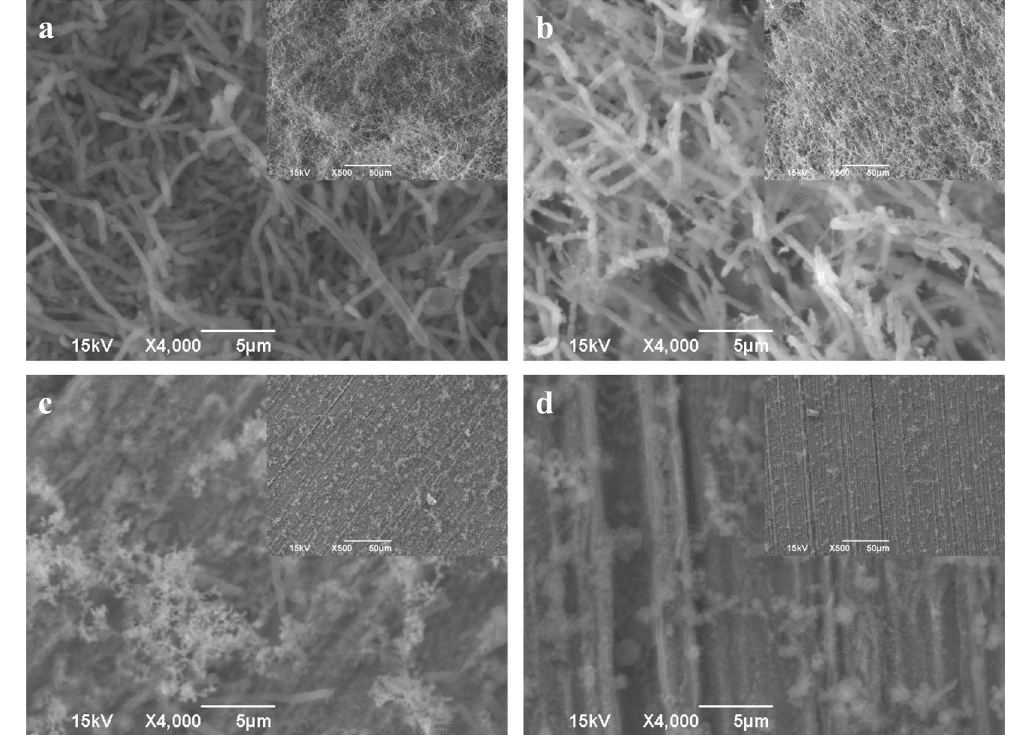
Figure 2. SEM images of PA biofilms on C1018 after the 7-day biofilm prevention test with: ( a ) no treatment (control), ( b ) 2 ppm D-tyr, ( c ) 30 ppm CIP, and ( d ) 30 ppm CIP + 2 ppm D-tyr. (Scale bars in the small inserted images are 50 μ